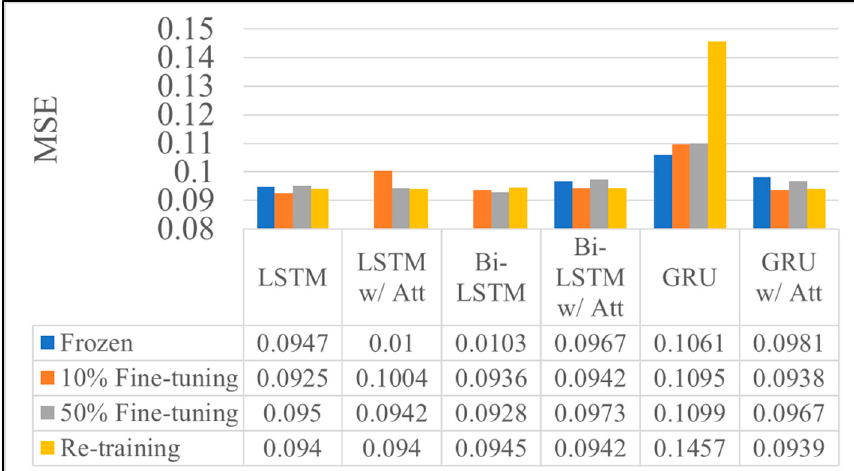
Figure 10. MSE of the source disease course prediction of TL-CDC under k = 3.